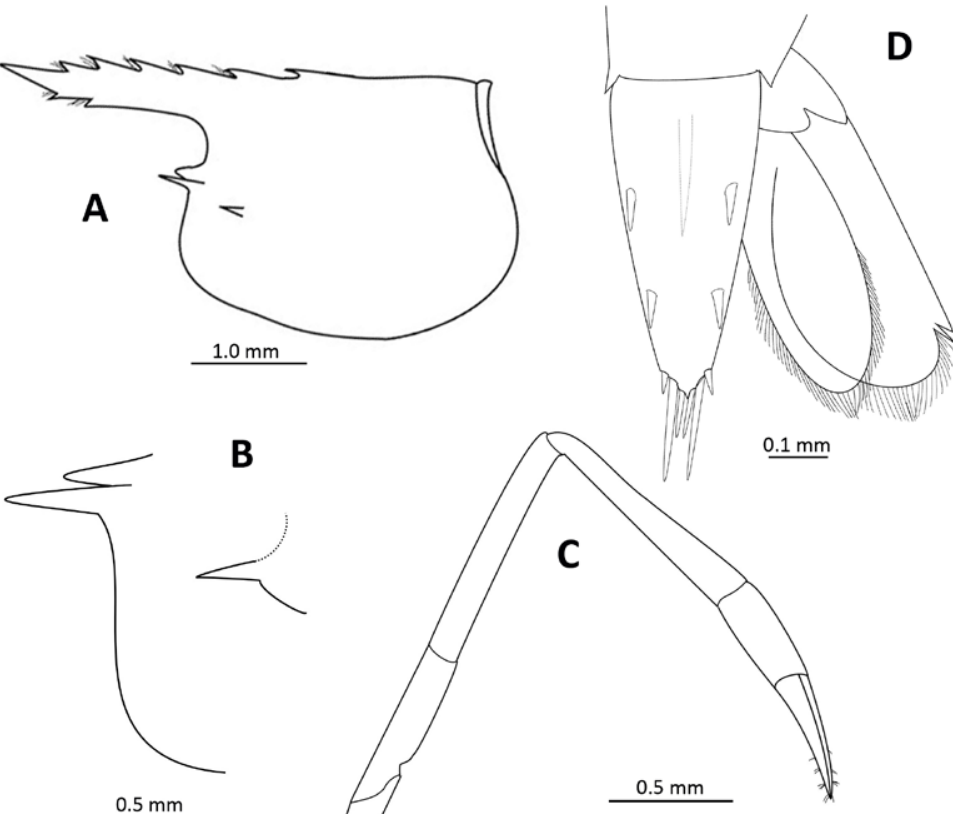
Figure 4. Palaemonella rotumana (Borradaile, 1898) (male, CL 2.5 mm) from the Lakshadweep Islands. A , lateral view of carapace; B , closer view of antennal spine; C , lateral view of the first pereiopod; D , dorsal view of telson.